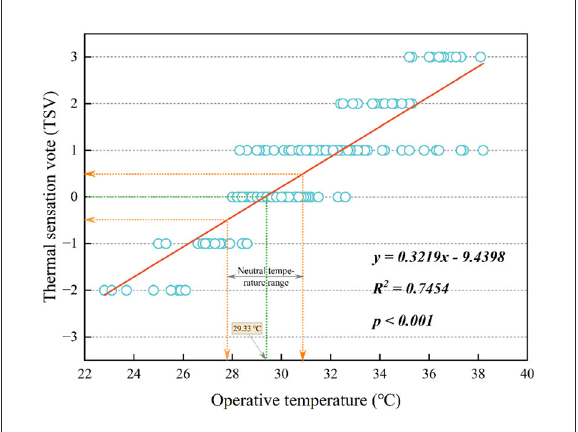
FIGURE10 Results of the linear regression between TSV and T op